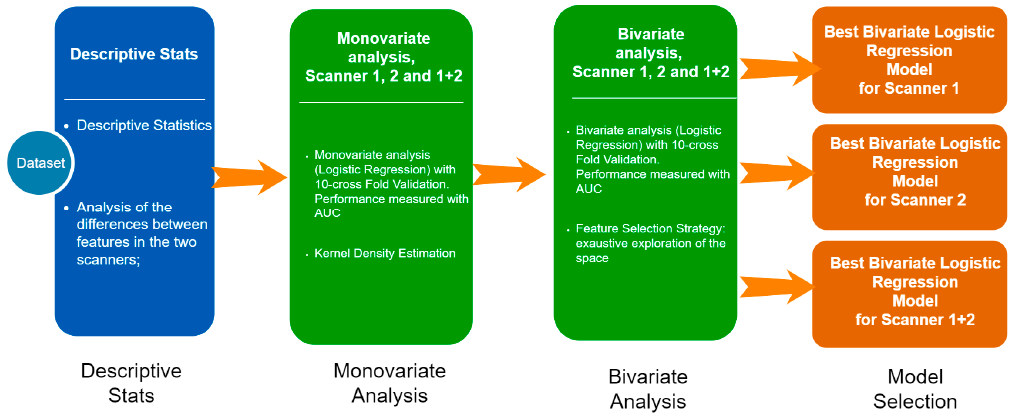
Figure 2. Résumé of statistical analyses performed. Figure 2. R é sum é of statistical analyses